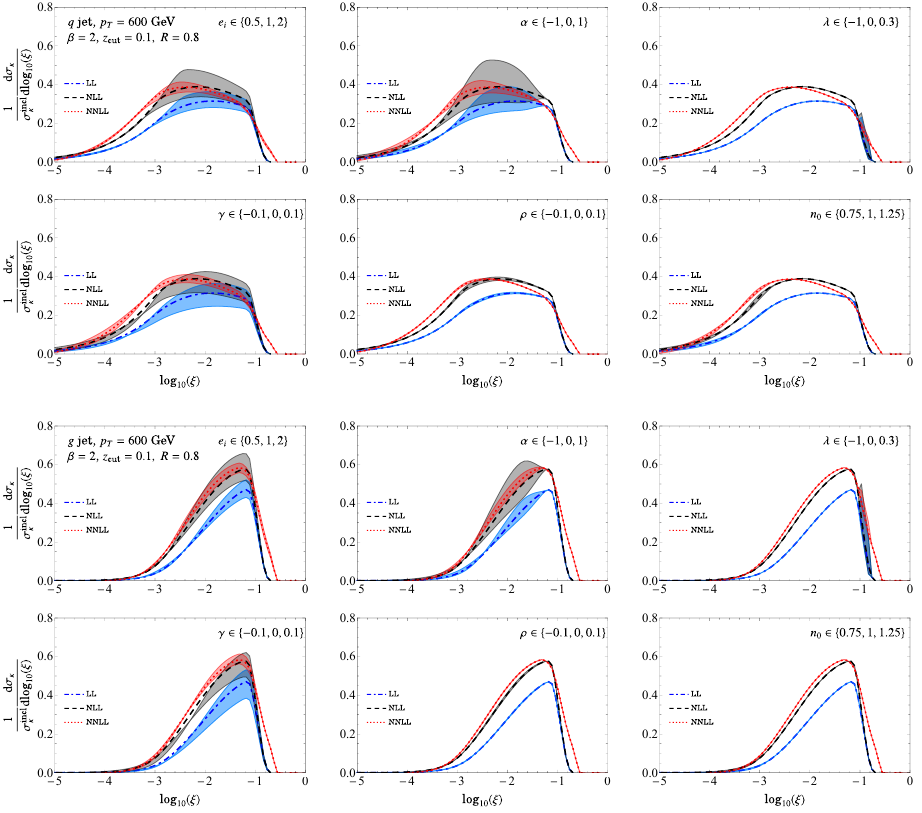
Figure 19 . Variations for each of the six different profile-variation parameters individually, for quark and gluon jets at p = 600 GeV, with β = 2 . T